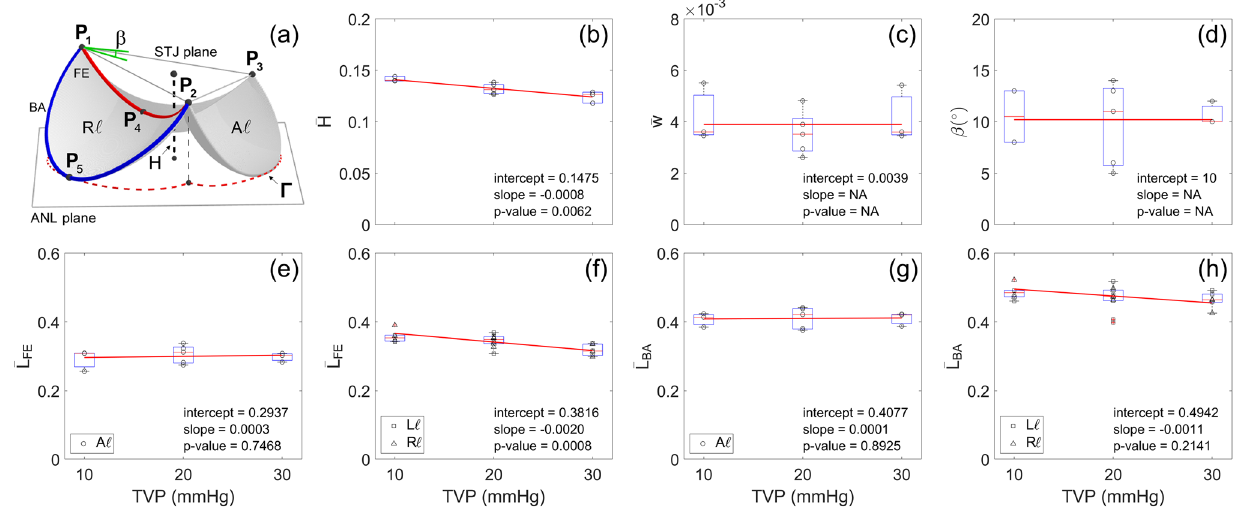
Figure 5. Local and global gQOIs were used to characterize the geometry of murine PVs under different TVPs. ( a ) schematic showing the key gQOIs. ( b – h ) show the trend of all gQOIs w.r.t TVP in which dimensional quantities were normalized using the valve perimeter length L Γ (see Table 1). The boxplot with whisker displays the minimum, first quartile, median, third quartile and maximum of the data (from bottom to top) with individual measurement shown in symbols. The linear regression fit of the measurement with respect to the TVP is shown in red solid line. The p-value for the t-statistic tests the hypothesis that the slope of the regression model is equal to zero or not. As p-value is < 0.05, it indicates statistically significant change of a gQOI w.r.t. characterized by a smaller normalized free edge and basal attachment lengths at all TPVs. The ratio of the mean free edge length between the anterior leaflet and left & right leaflets, which is approximately 0.81 at 10 mmHg, gradually increases to 0.94 at 30 mmHg. For the basal attachment length, similar trend is observed with the ratio increasing from 0.84 at 10 mmHg to 0.89 at 30 mmHg. These indicate the relative size of the anterior leaflet in the PV increases with increasing TVP, which is likely due to greater PA distention in the anterior direction. Note, while the normalized free edge and basal attachment lengths in the left and right leaflets decrease, there are grounds to believe that both the free edge and basal attachment are elongated when TVP increases but in a rate less than the increase of valve perimeter length. Similarly, the height of the PV is also likely to increase at larger TVP. These hypotheses, unfortunately, cannot be justified from our experiment since the absolute change of the gQOIs is not available for the same PV. Results for shape analysis of the leaflets revealed remarkable consistency at each TVP level (Fig. 6). The plots of the individual leaflets were segregated by their overall size, where the left and right leaflets were geo- metrically similar and symmetrical, while the anterior leaflet was noticeably smaller. The normalized height of ¯ h , is plotted against the outward circumferential direction (Fig. 6a), ¯ c , and radial direction (Fig. 6b), the leaflet, ¯ r , respectively, showing the cross-sectional profiles of murine PVs. By plotting these for increasing TVPs, it is more clearly revealed how the PV shape changed with TVP. Specifically, we found that in the circumferential direction, the cross sections first undergo a slightly increased inflation from 10 to 20 mmHg with little change in the overall profile. From 20 to 30 mmHg, the relative height of the cross section with respect to the span in the circumferential direction decreases noticeably for all the leaflets. In the radial direction, interestingly, that the inflation of the cross section with respect to the ANL plane is inversely proportional to the TVP. At 10 mmHg, the inflation is the most significant with almost the entire cross sections below the ANL plane for all the leaflets. At 20 mmHg and 30 mmHg, the angle of the cross section with respect to the ANL plane at the basal attachment end gradually increases leading to a lower profile of the leaflets above the ANL plane. This phenomenon appears to be a combined effect of increasing TVP, leaflet stiffening, and distention of the PA. Qualitatively, it can be explained in the following: Increasing TVP leads to distention of the PA which stretches the leaflets in the circumferential direction. Stretched leaflets stiffens in both the circumferential and hence changes the equilibrium profile of the radial cross section. There appears to be no major difference observed in the overall leaflet profiles, except that the circumferential cross section of the anterior leaflet is approximately symmetric. Additionally, both left and right leaflets were asymmetric with respect to the circumferential direc- tion due to the nonzero tilt angle between the STJ and ANL planes. Overall, the normalized geometry results (Figs. 5, 6) provide a clear picture of how the murine PV adapts to TVP. Briefly, at 10 mmHg all leaflets are significantly enlarged in the radial direction. While the anterior leaflet is about 80% of the left and right leaflets in size, the profiles of the normalized central radial cross sections are similar for all the leaflets. At 20 mmHg, the anterior leaflet gets larger relatively due to the nonuniform PA disten- tion. This contributes to a slight decrease in the normalized free edge and basal attachment lengths in the left and right leaflets. The PA distention also leads the radial cross section to become flatter at the basal attachment end with respect to the ANL plane. Meanwhile, the normalized valve height decreases slightly although the actual